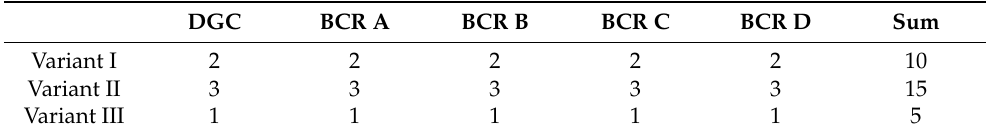
Table 4. Results of centralized sewage management economic sustainability assessment, 3 points—the best option, 1 point—the weakest option.